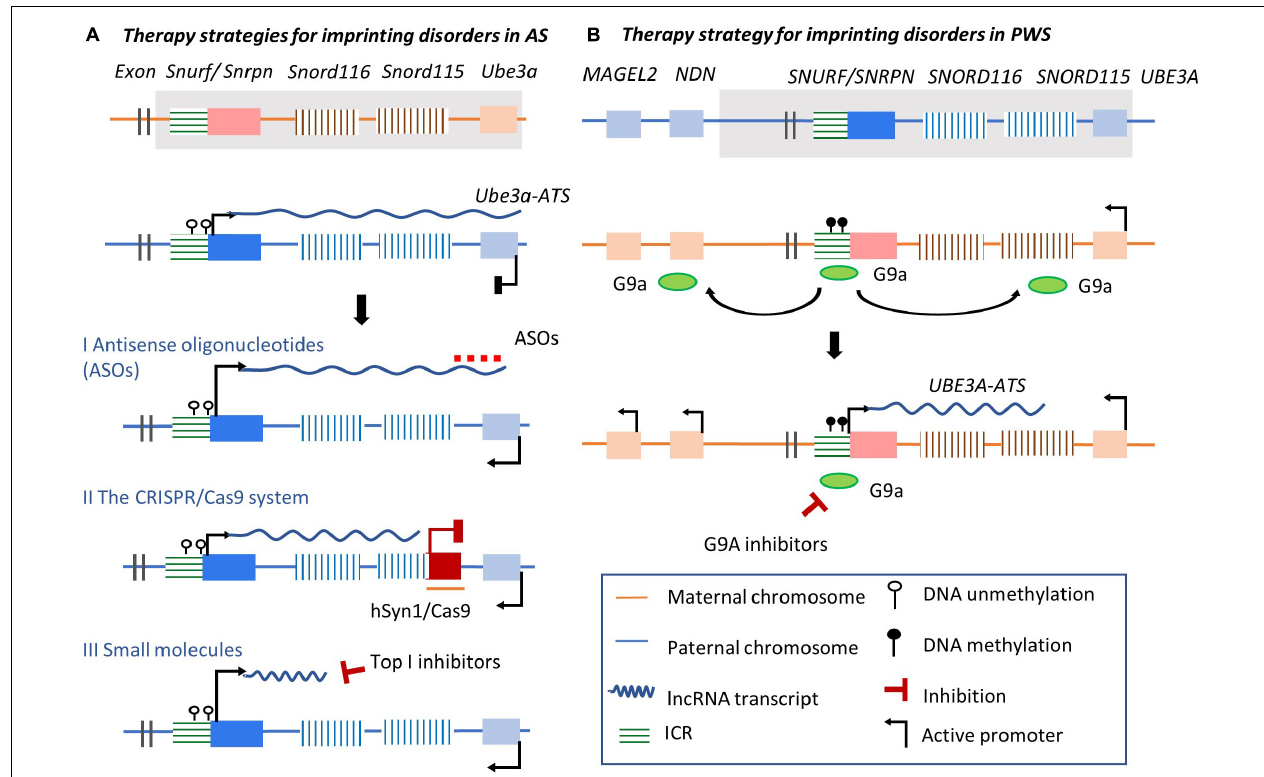
FIGURE 6 | Three state of the art strategies for imprinted disorders via targeting imprinted lncRNAs. (A) Therapeutic strategies for AS. Molecular alterations such as deletions in Ube3a/Ube3a-ATS imprinted cluster can cause the loss of effective Ube3a expression. Line I: ASOs are designed to target the overlapping regions of Ube3a-ATS transcripts and Ube3a , releasing paternal Ube3a expression; Line II: the human synapsin 1 (hSYN1) gene promoter is used drive neuron-specific expression and Cas9 packaged with adeno-associated virus delivering system is inserted into the gene region of the Snord115 , leading to disrupted transcription of Ube3a-ATS before extending to the Ube3a gene encoding region. Line III: Top I inhibitors disrupt the elongation of the Ube3a-ATS at the Snord116 region. Ube3a paternal expression is released from transcriptional collision. (B) Therapeutic strategy for PWS. G9A inhibitors prevent G9A recruitment to flanking regions near the ICR, releasing Ube3a-ATS lncRNA expression from its promoter in the